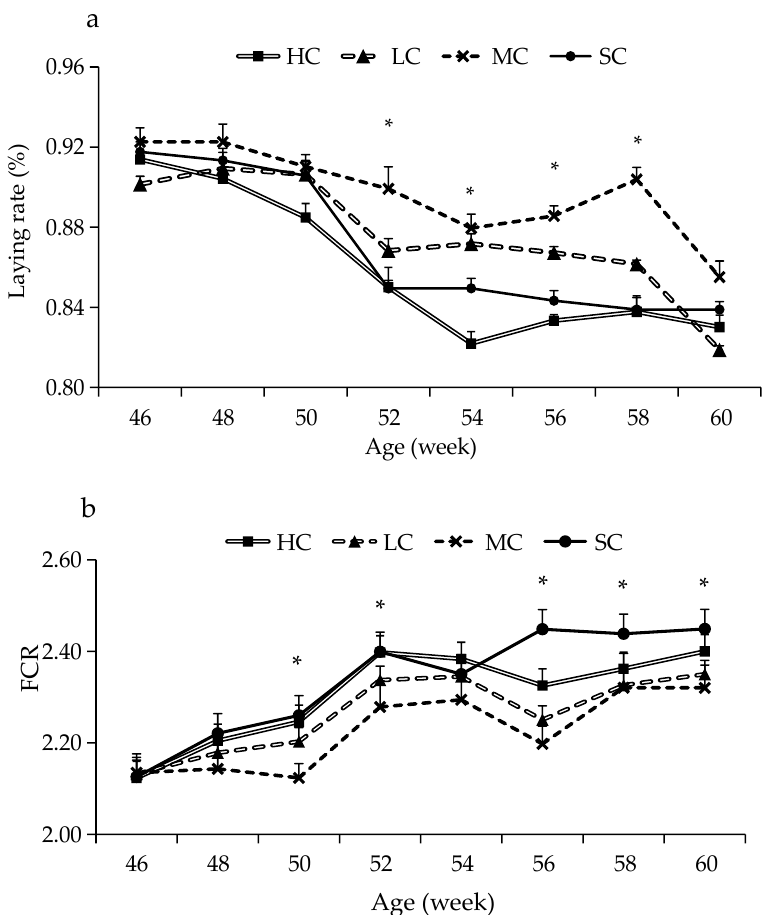
Figure 1. Laying rate ( a ) and feed conversion ratio (FCR) ( b ) of laying hens reared in different cage size groups from 46 to 60 weeks of age. HC, huge cage; LC, large cage; MC, medium cage; SC, small cage. * Within each time, means with an asterisk superscript are significantly different ( p < 0.05). Table 2. Effects of cage size on the overall production performance of laying hens from 46 to 60 weeks of age. Group